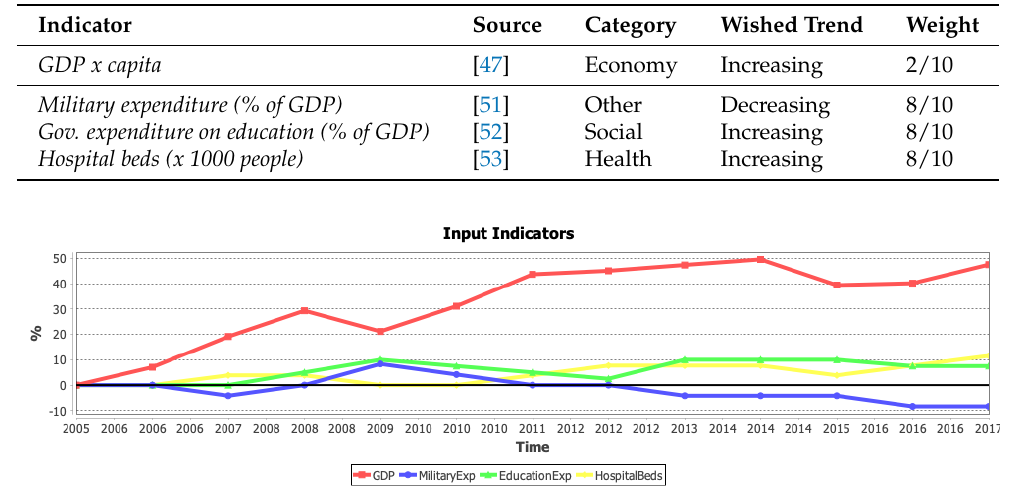
Figure 13. Input data trend for the time range 2005–2017 (Case Study 2).